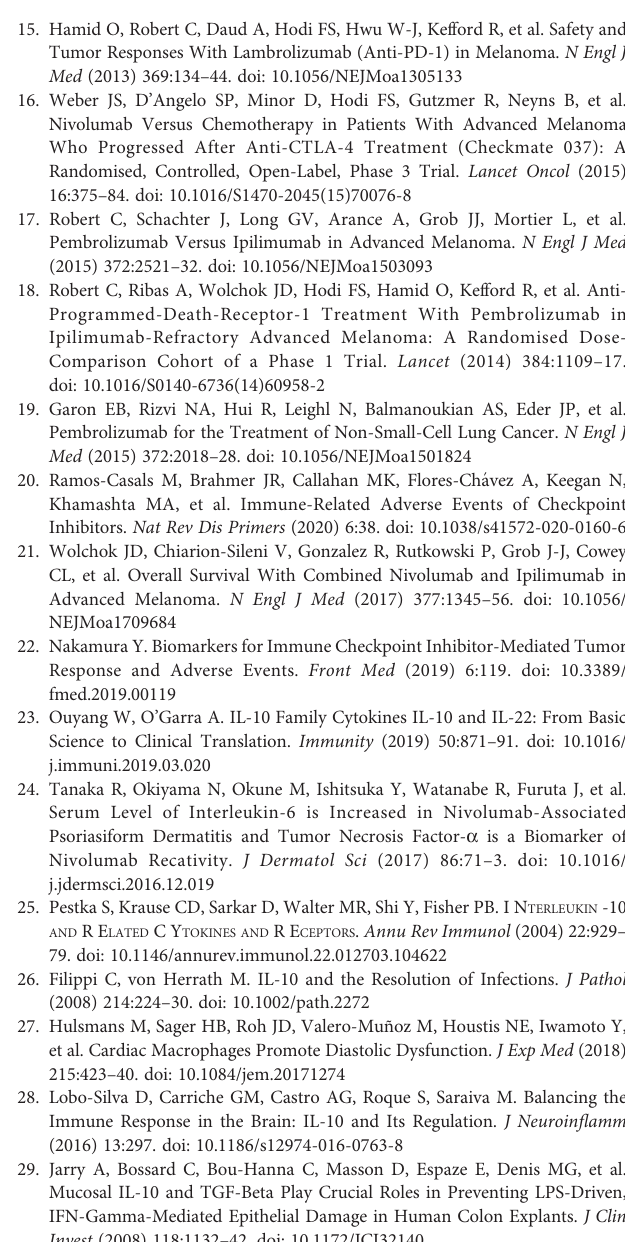
Supplementary Figure 1 | ROC curve analysis of all blood biomarkers included and irAEs. Supplementary Figure 2 | ROC curve analysis of all blood biomarkers included and ICI-pneumonitis. Supplementary Figure 3 | Grade distribution of irAEs (A) and ICI-pneumonitis (B) in patients with high IL-10 and low IL-10